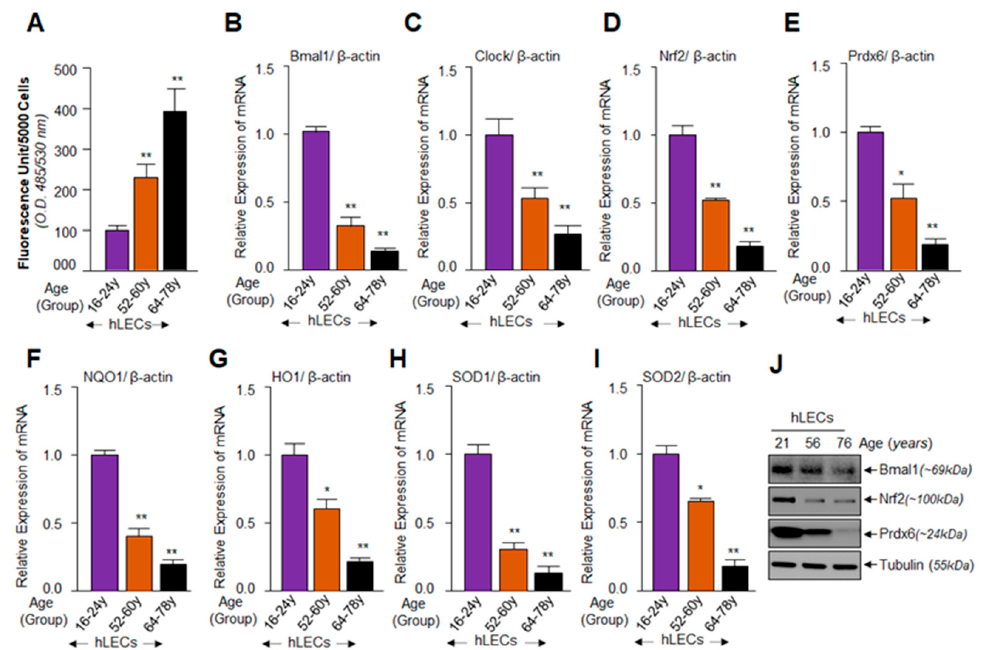
Figure 1. Aging human lens epithelial cells (hLECs) displayed increased levels of reactive